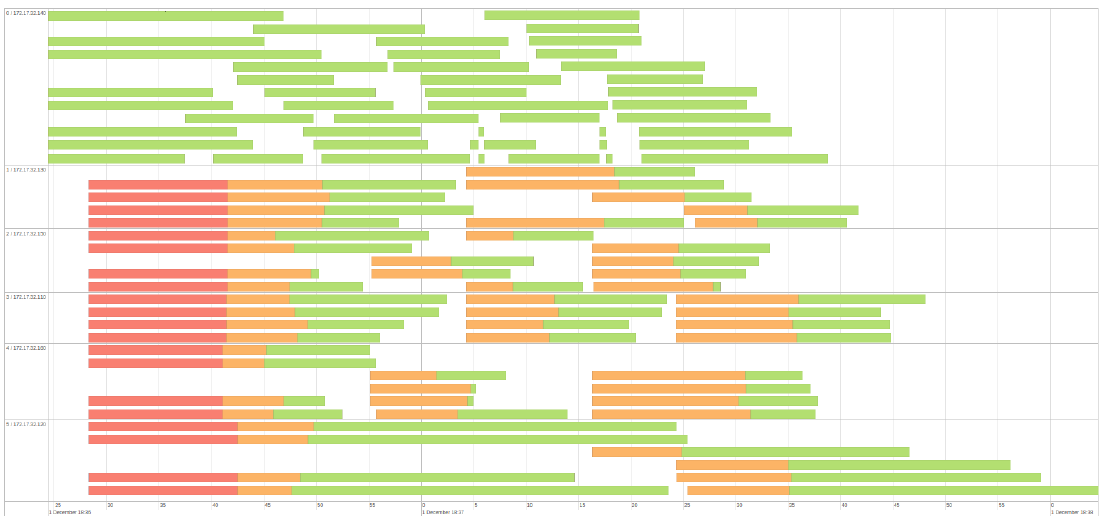
Figure 7. The tasks load after integrating the LoadPartitioner strategy.